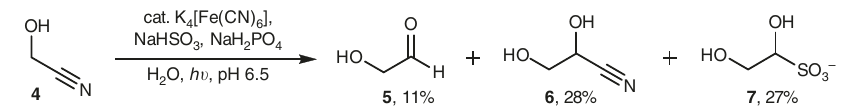
Fig. 3 Photochemical reduction of 4 using the Fe 2 + /NaHSO 3 system. Typical conditions: glycolonitrile 4 (30 mM), Na 2 SO 3 (50 mM), NaH 2 PO 4 (100 mM) and K 4 [Fe(CN) 6 ] (5 mM) in H 2 O:D 2 O (9:1), pH adjusted to 6.5 with degassed HCl/NaOH and the solution was irradiated. Glyceronitrile 6 was presumed to be formed due to the liberation of cyanide in the work-up procedure, whereby paramagnetic Fe x (CN) y L z species were removed by the addition of NaSH to allow NMR spectra to be